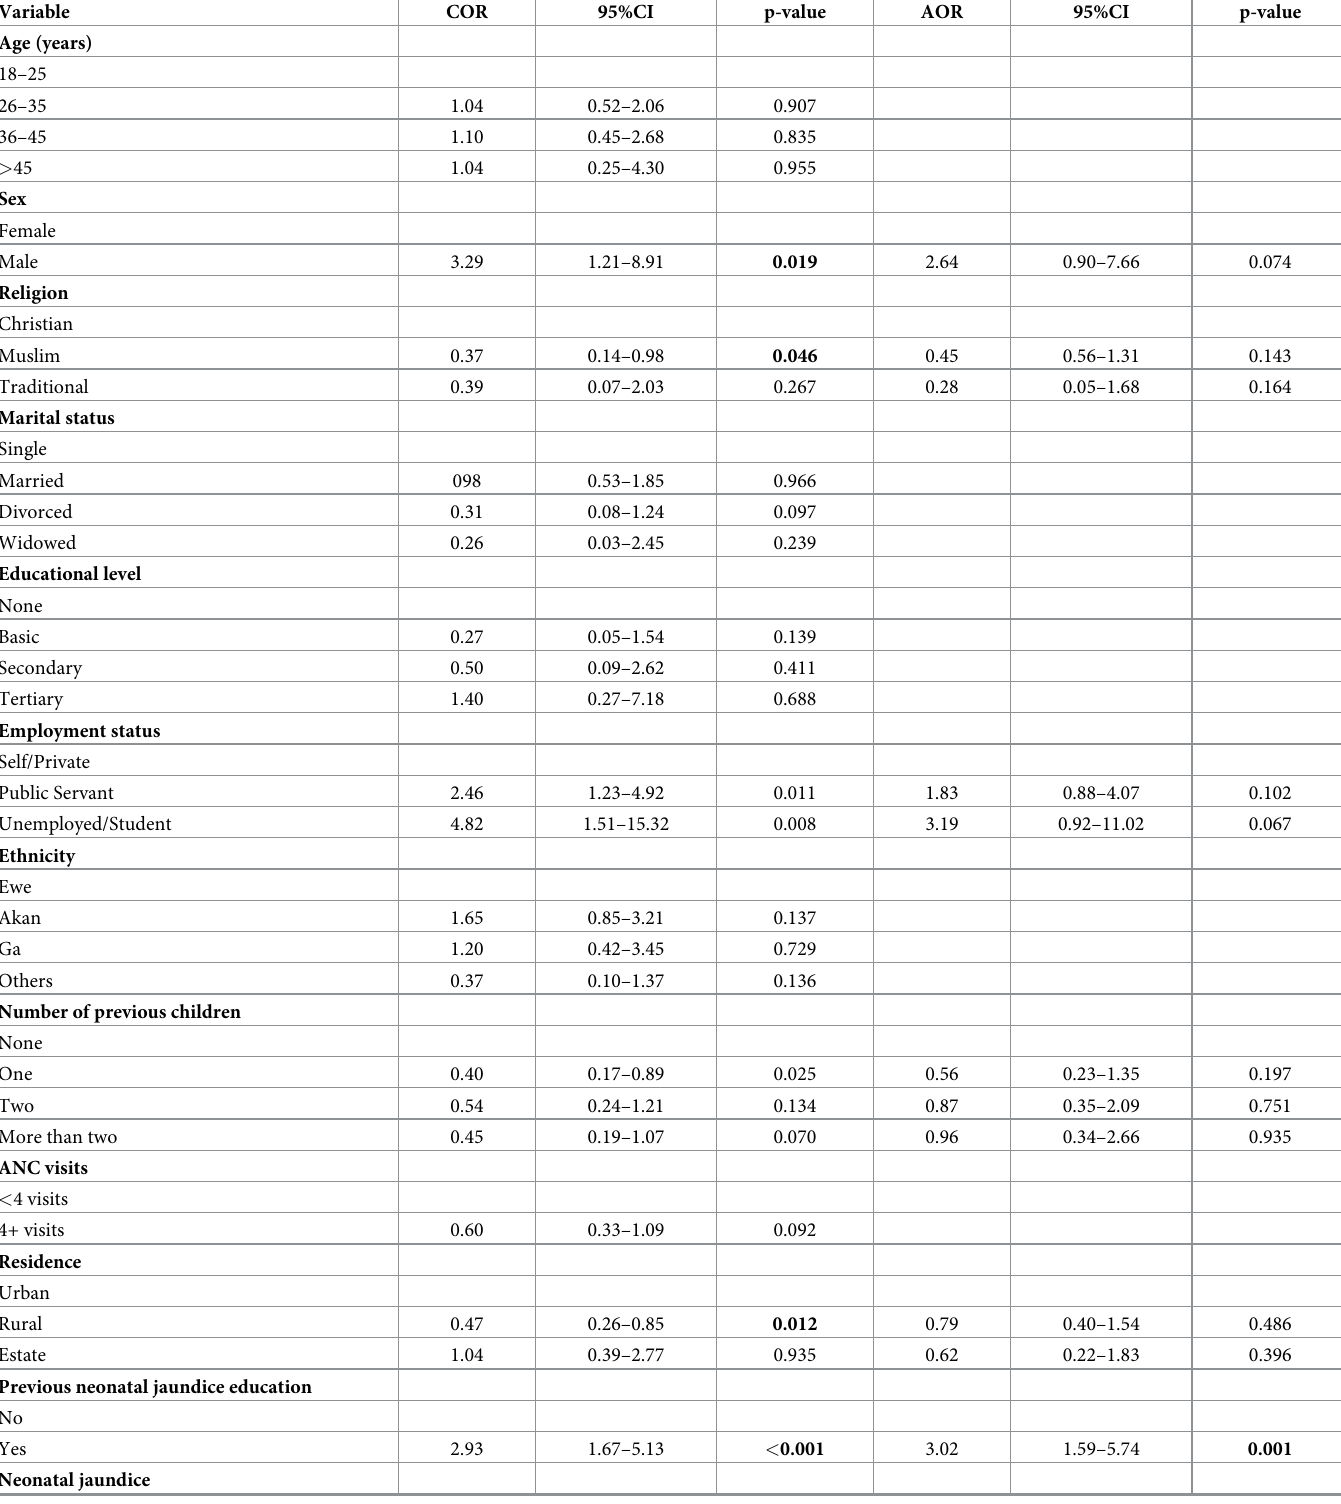
Table 5. Logistic regression results showing factors associated with knowledge of neonatal jaundice among